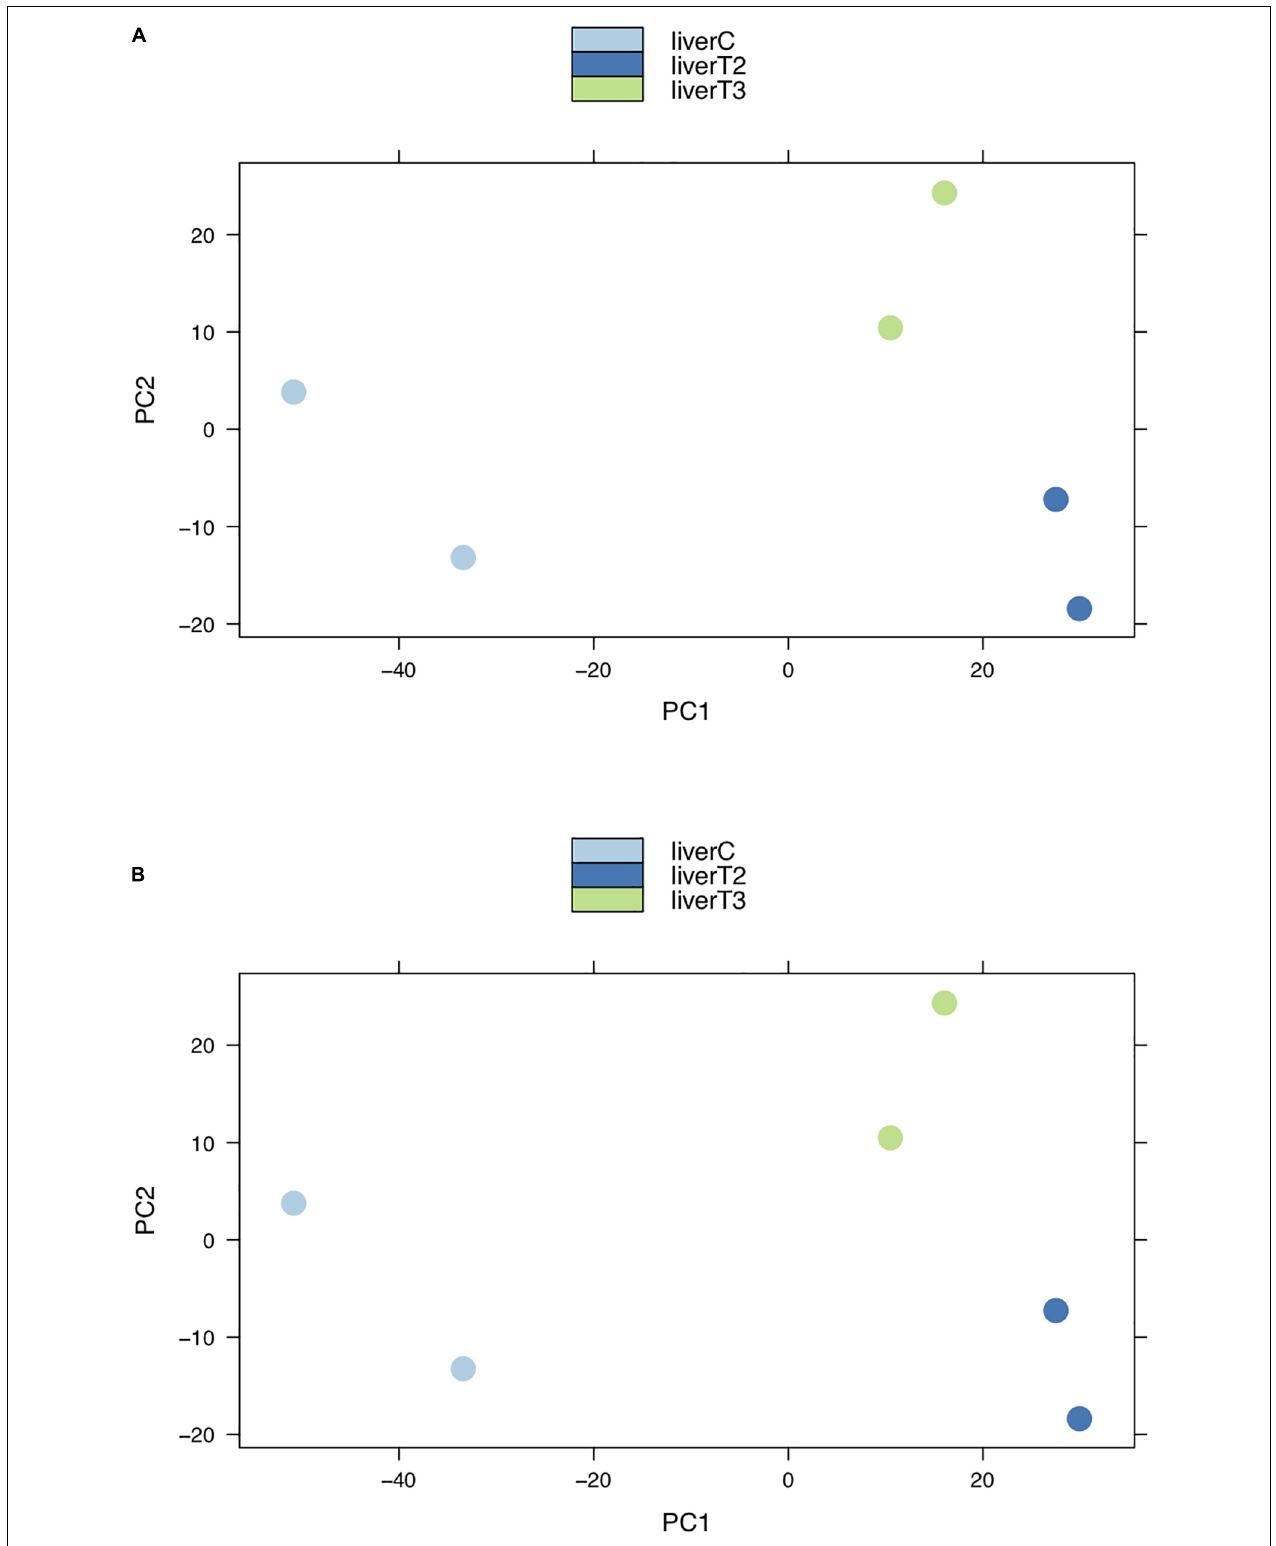
FIGURE 5 | PCA plots. Groups of samples can be analyzed using Principal Component Analysis (PCA) plots where replicates of a certain conditions are clustered together. Clusters from different conditions are separated. (A) log2 normalized counts. (B) TMM normalized counts.